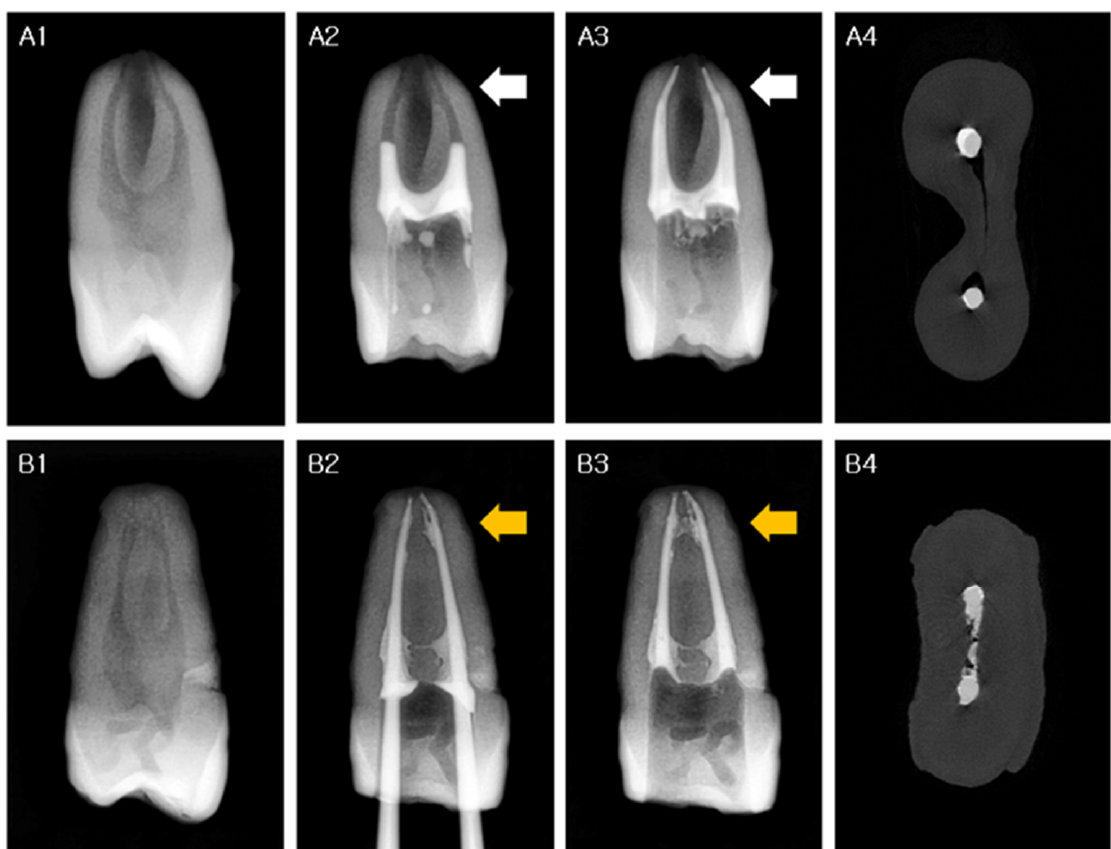
Figure 3. Representative images of root canal sealer movement at the apical thirds of SE group ( A1 – A4 ) and VG group ( B1 – B4 ). ( A1 , B1 ): pre-operative standard radiographic images of each group. ( A2 – A4 ): before ( A2 ) and after ( A3 ) single- cone technique + Endoseal TCS; micro-CT cross-section image at the apical thirds ( A4 ), indicated by the white arrow in ( A2 , A3 ). Movement of Endoseal TCS into the complex apical anatomy can barely be noticed. ( B2 – B4 ): before ( B2 ) and after ( B3 ) the VibraTHO technique + GuttaFlow 2; micro-CT cross-section image at the apical thirds ( B4 ), indicated by the yellow arrow in ( B2 , B3 ). Even though it is not perfectly filled, hydrodynamic movement of GuttaFlow 2 into the complex apical anatomy after application of the VibraTHO technique is clearly observed. CT: computed tomography, VibraTHO: ultrasonic vibration and thermo-hydrodynamic obturation.